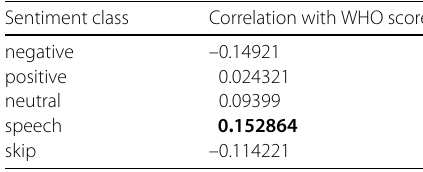
Table 15 Correlation between sentiment class and WHO score